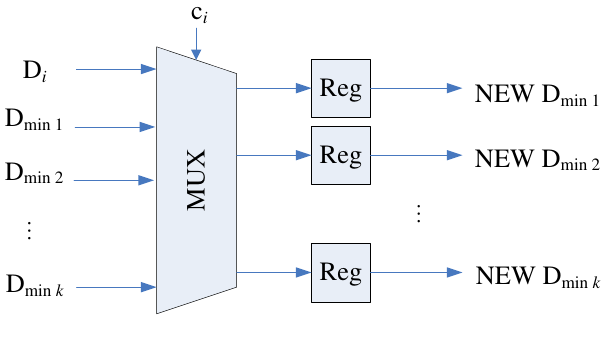
Figure 9. The architecture of the distribution unit.